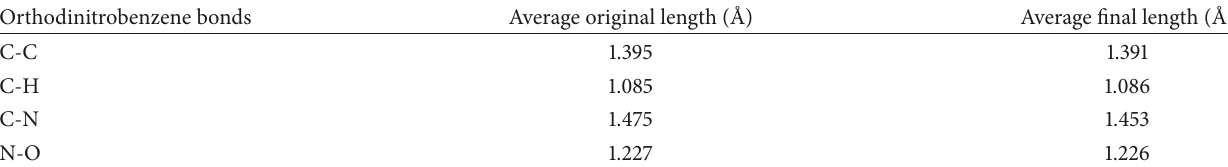
Table 2: The effect of relaxing the scan constraints at the orthodinitrobenzene minimum energy